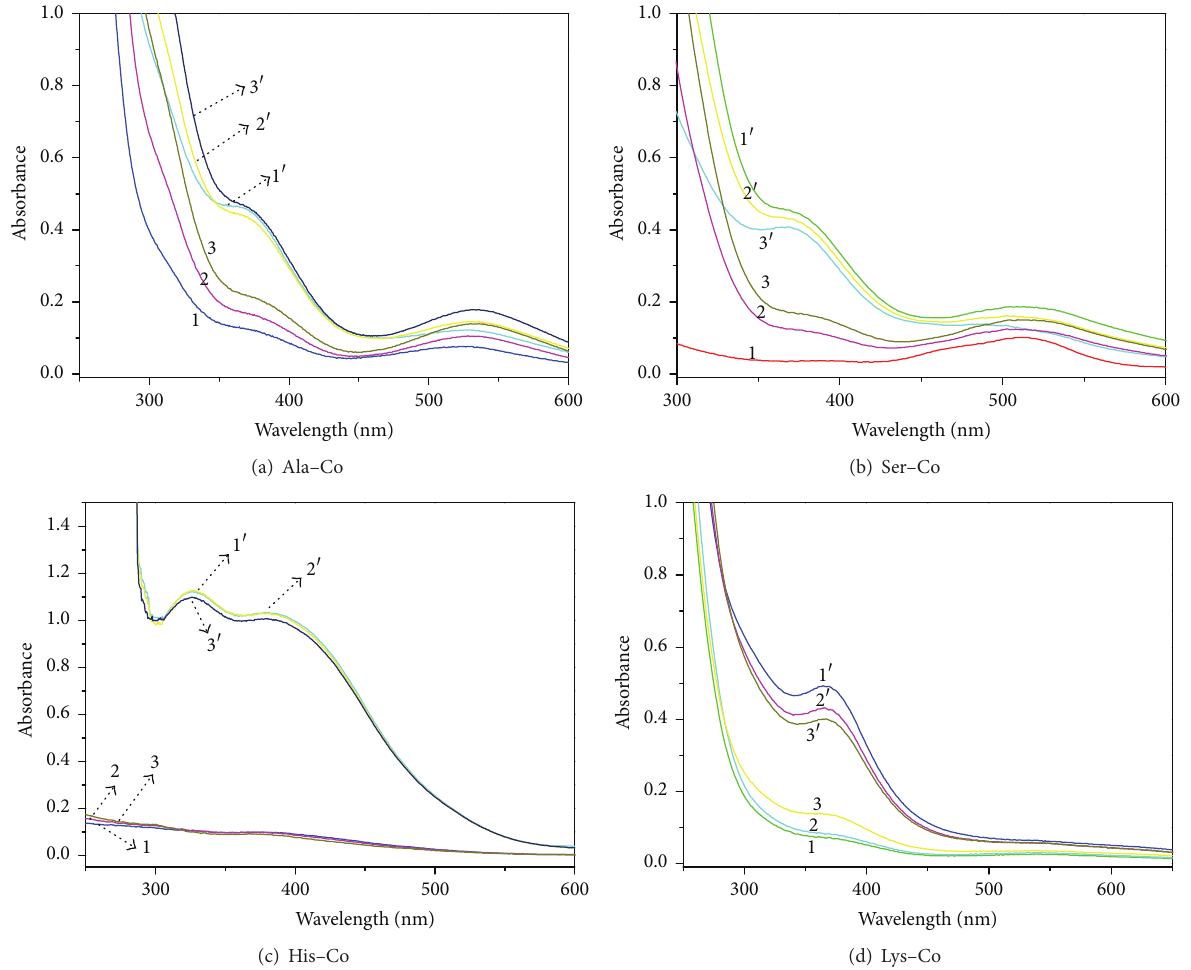
Figure 1: Reversible performance of L–Co was determined by UV-vis spectrophotometry (curves 1, 2, and 3 were tested in nitrogen, and curves 1 󸀠 , 2 󸀠 , and 3 󸀠 were tested in an oxygen